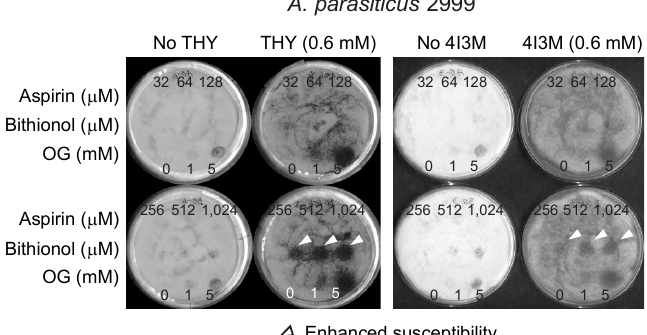
Figure 4. Enhancement of antifungal activity of bithionol by thymol or 4I3M tested in the aflatoxigenic A. parasiticus 2999. THY, thymol; 4I3M, 4-isopropyl-3-methylphenol; OG, octyl gallate (positive control).